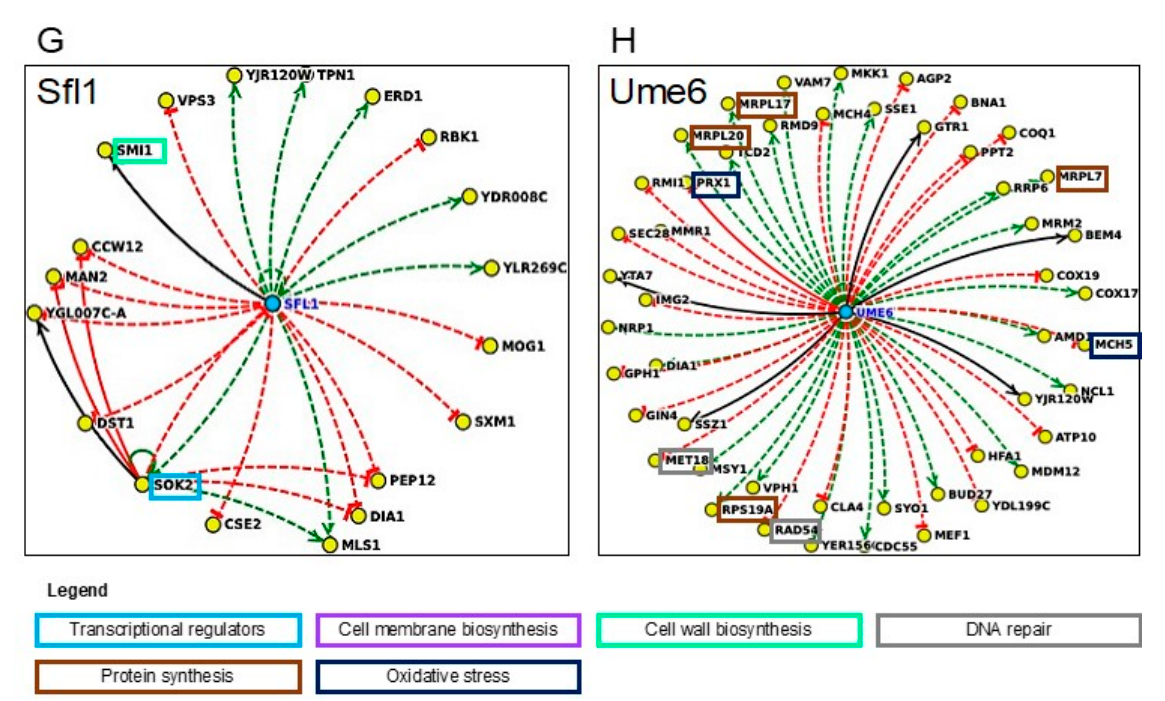
Figure 6. Genetic interaction networks between the TFs Gln3 ( A ), Ixr1 ( B ), Opi1 ( C ), Rph1 ( D ), Sok2 ( E ), Stb5 ( F ), Sfl1 ( G ) and Ume6 ( H ), required for tolerance to methanol and the methanol tolerance genes identified in this study that are their documented targets. The interaction networks were obtained using the regulatory interactions available in Yeastract (December 2020, http://yeastract-plus.org/yeastract/scerevisiae/index.php). The positive, negative, and unspecified regulatory interactions, correspond, to green, red, and black lines, respectively. The interactions are based in expression data (dashed lines) or DNA binding (full lines). The color of the boxes represents different functional groups as indicated in the legend.